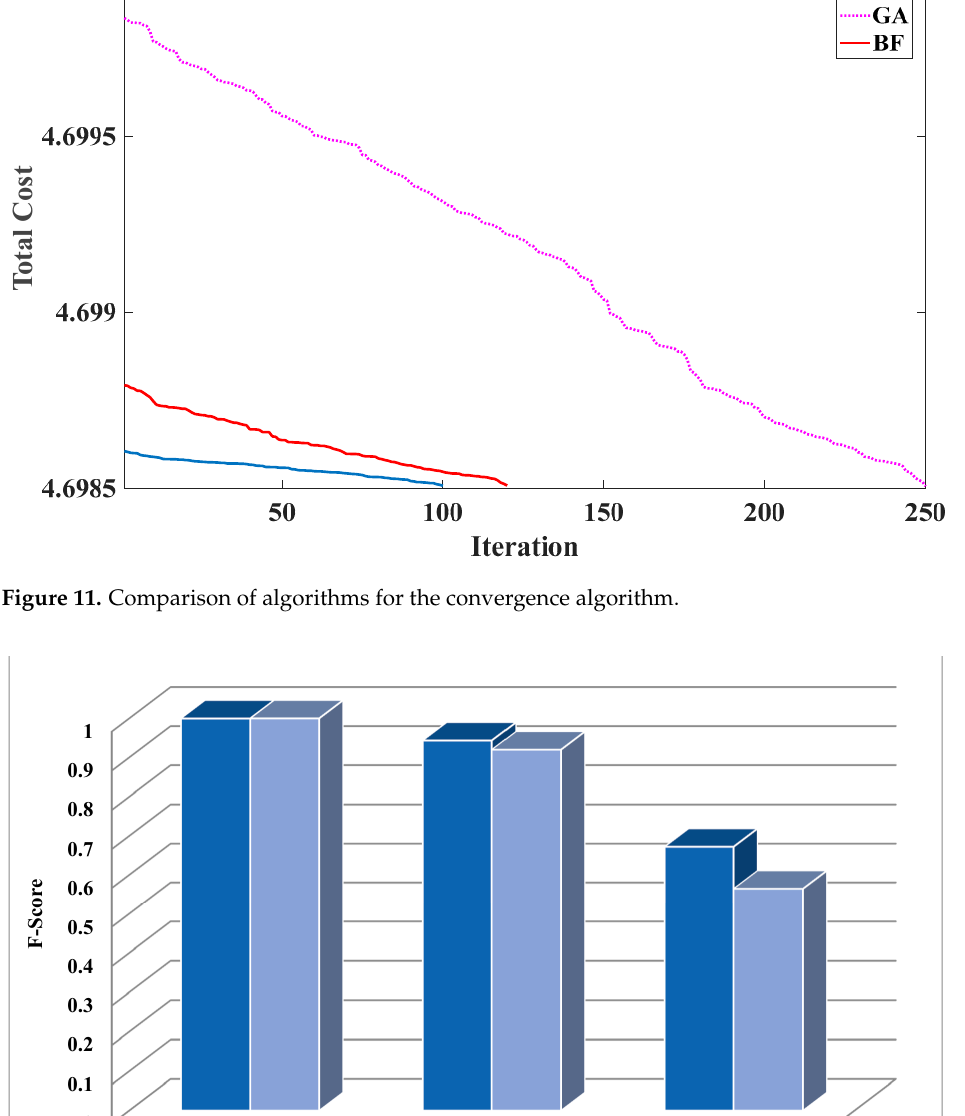
Figure 12. Illustration of the compared results for different detection approaches.